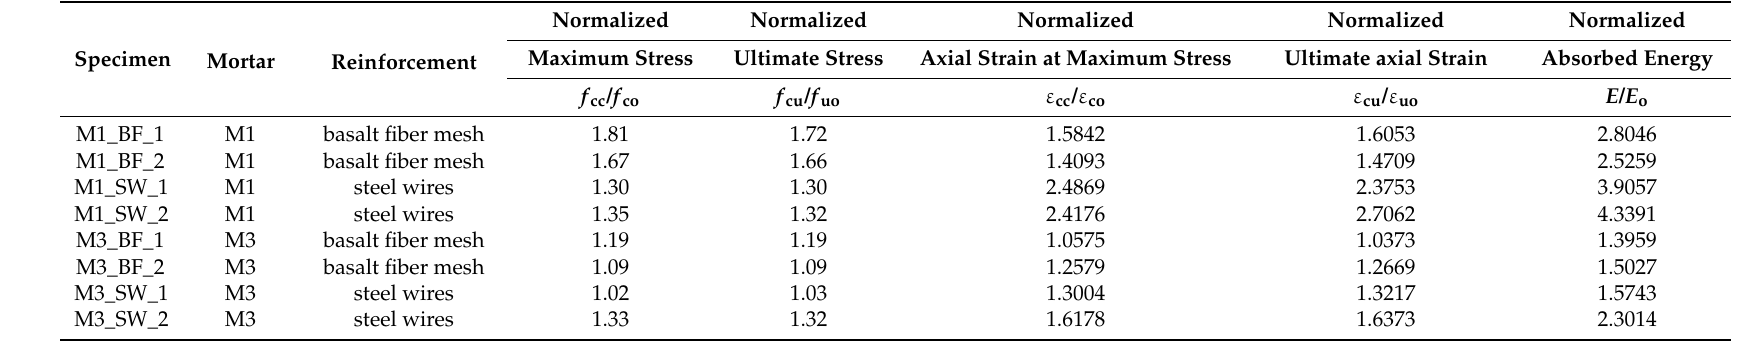
Table 2. Details of confined brick masonry columns and key